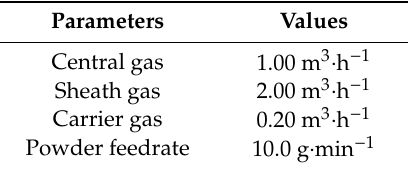
Table 3. Typical experiment